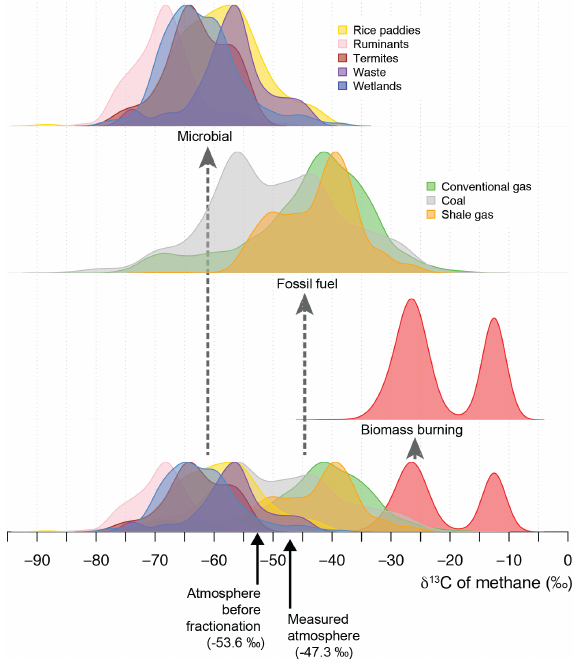
Figure 7. Normalized probability density distributions for the δ 13 C CH of microbial, fossil, and biomass burning sources of 4 methane. The flux-weighted average of all sources produces a mean atmospheric δ 13 C CH of ∼− 53.6‰, as inferred from measured at- 4 mospheric δ 13 C CH and isotopic fractionation associated with pho- 4 tochemical methane destruction (see